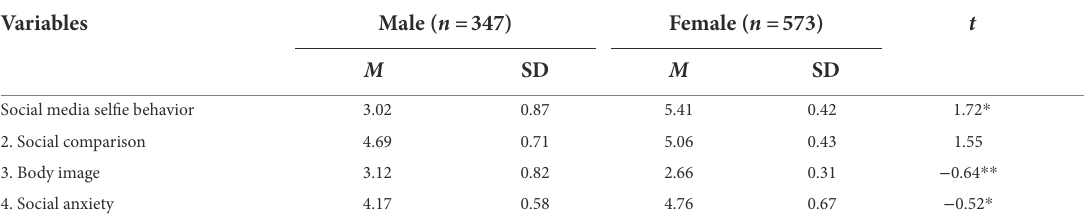
TABLE 4 Analysis of differences among variables in gender, education level, and living location. Test for differences in each variable on